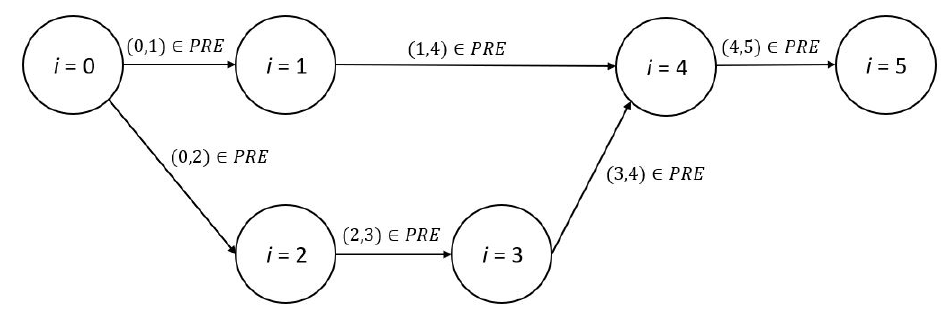
Figure 1. Network diagram of a